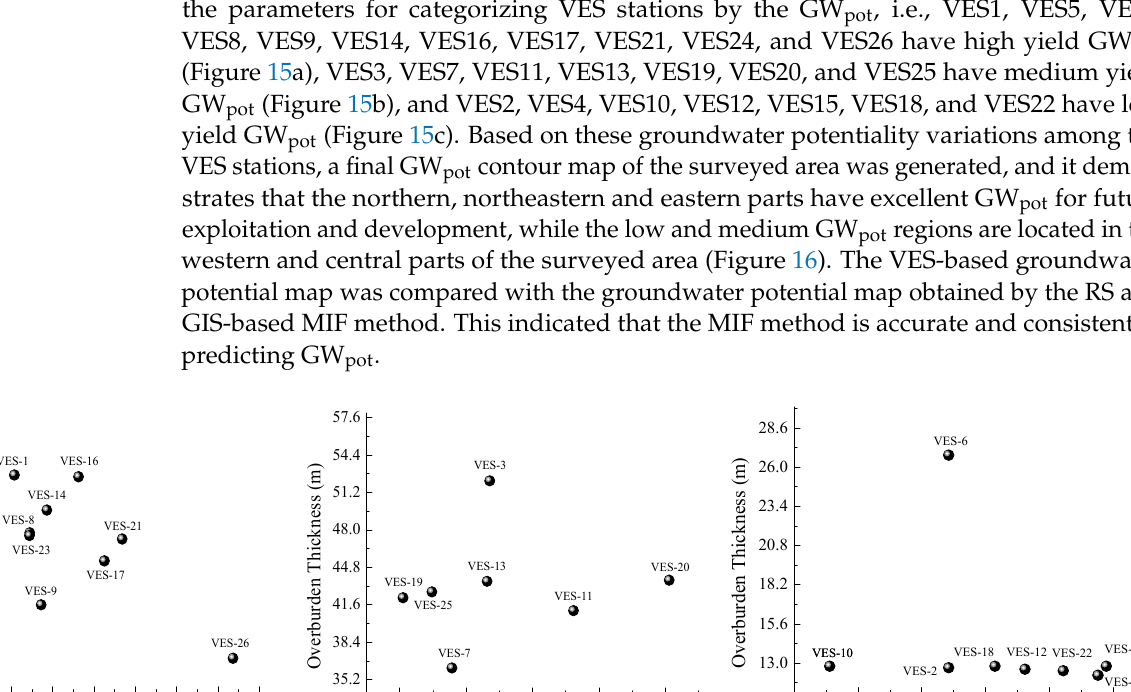
Figure 14. ( a ) Reflection coefficient map; ( b ) overburden thickness map; ( c ) apparent resistivity map based on the inter- pretation of VES data.